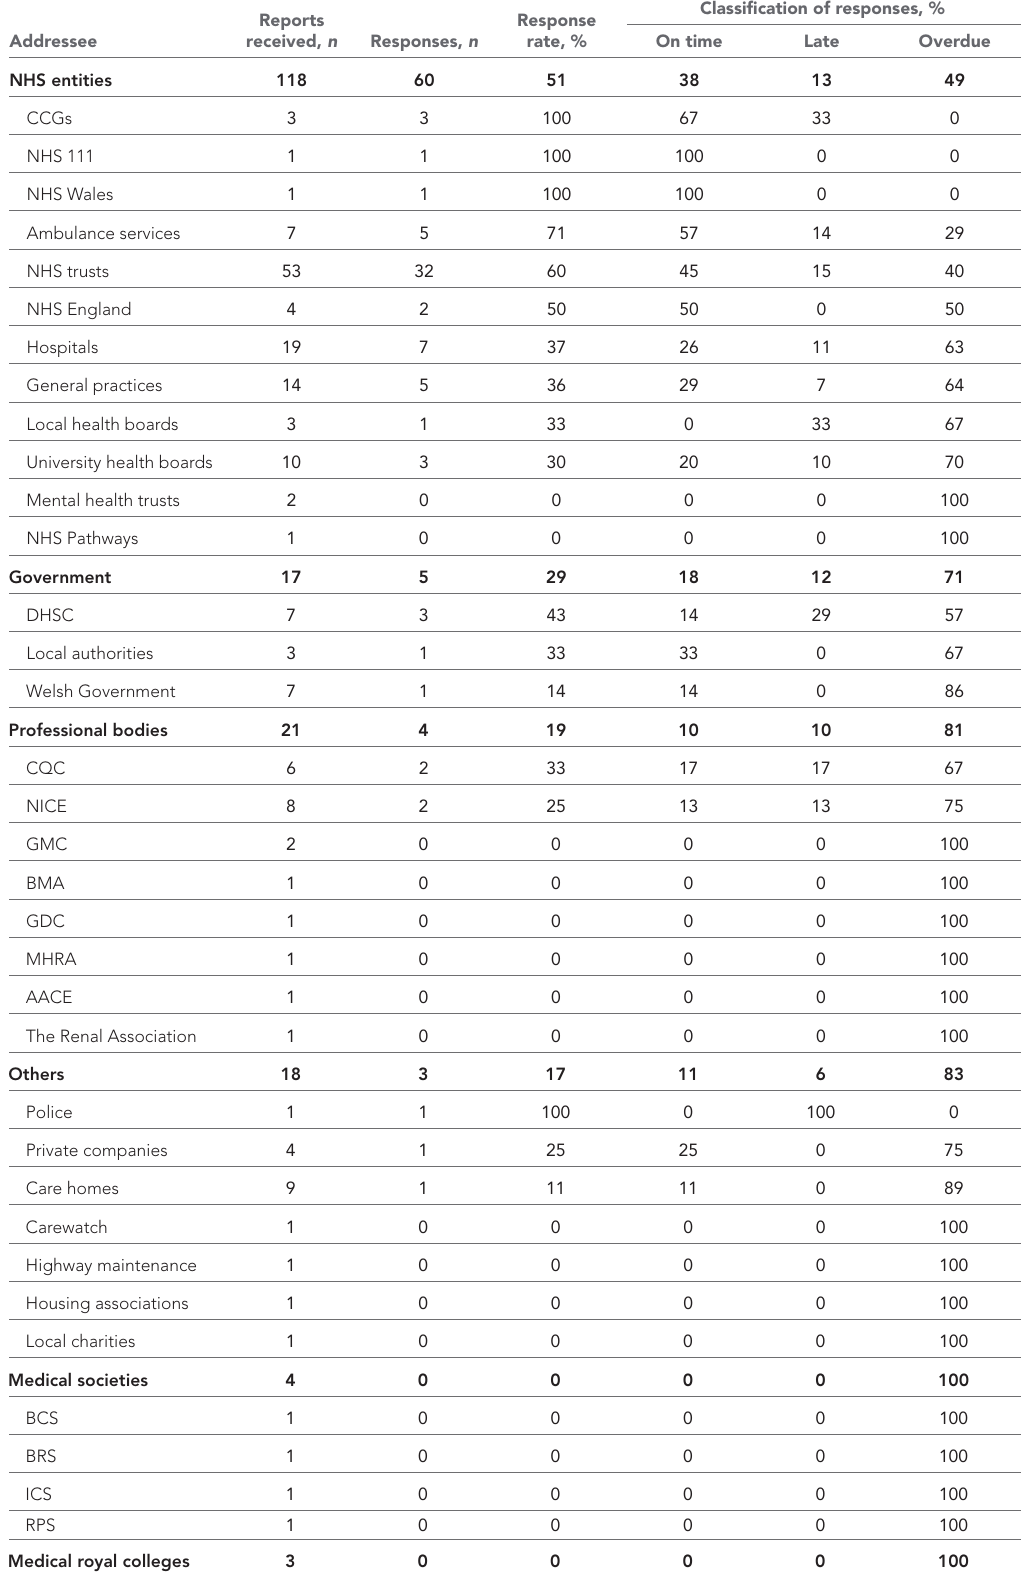
Table 2 Recipients of coroners' Prevent Future Death reports (PFDs) and their response rates